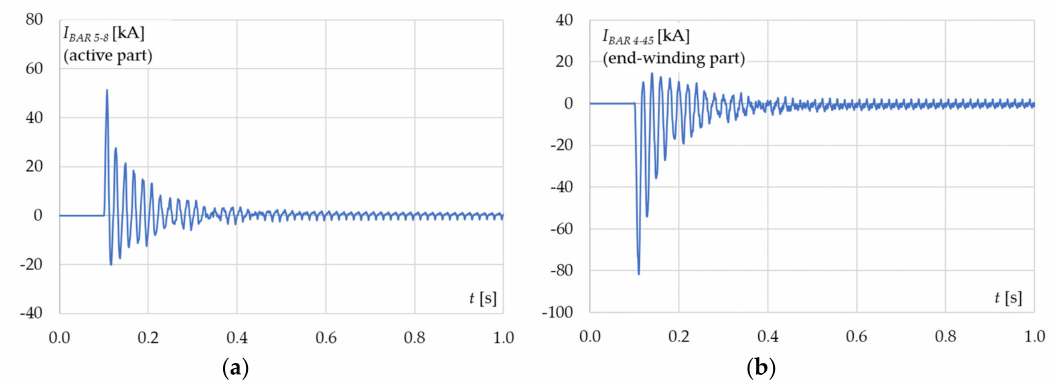
Figure 28. Waveforms of induced current in bar No. 5-8 ( a ) and circuited segment No. 4-45 ( b ) during the first second of sudden short